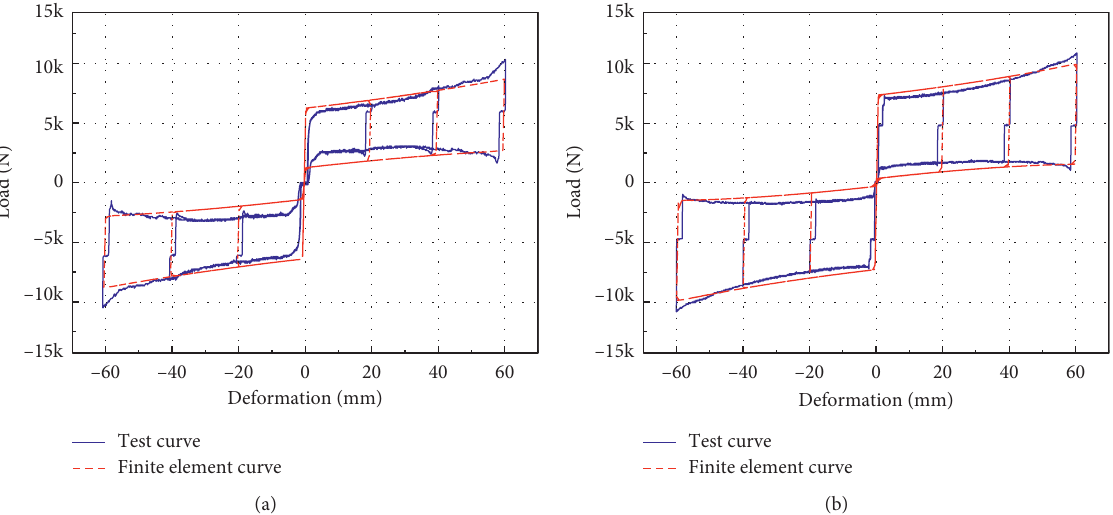
Figure 13: Hysteresis curves of test and finite element (SCVF brace with spring S2). (a) 5 mm deflection of the friction plate. (b) 7.5mm deflection of the friction